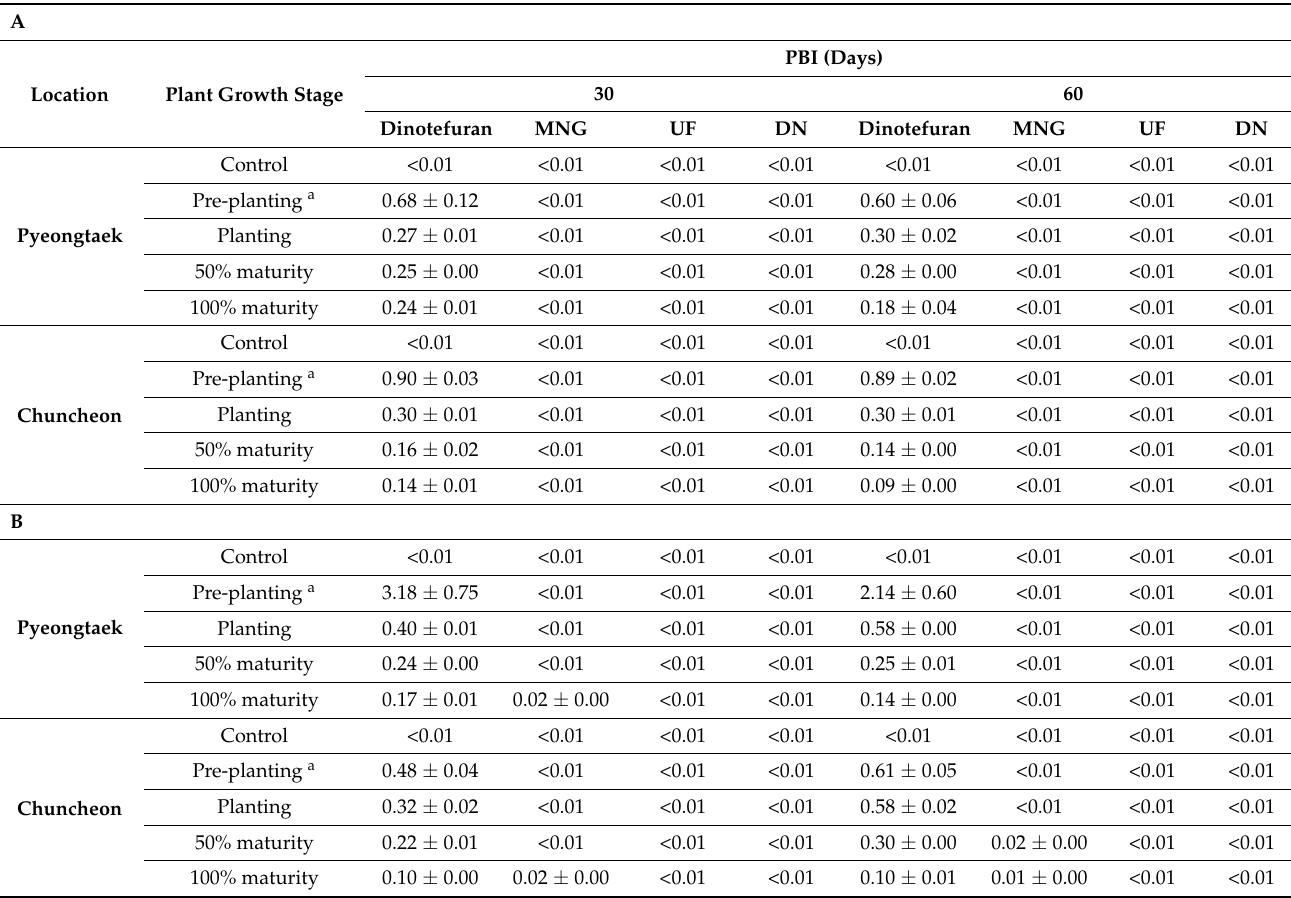
Table 1. Average * concentration of dinotefuran and its metabolite residues (mg/kg) remaining in soil of ( A ) lettuce and ( B ) celery.